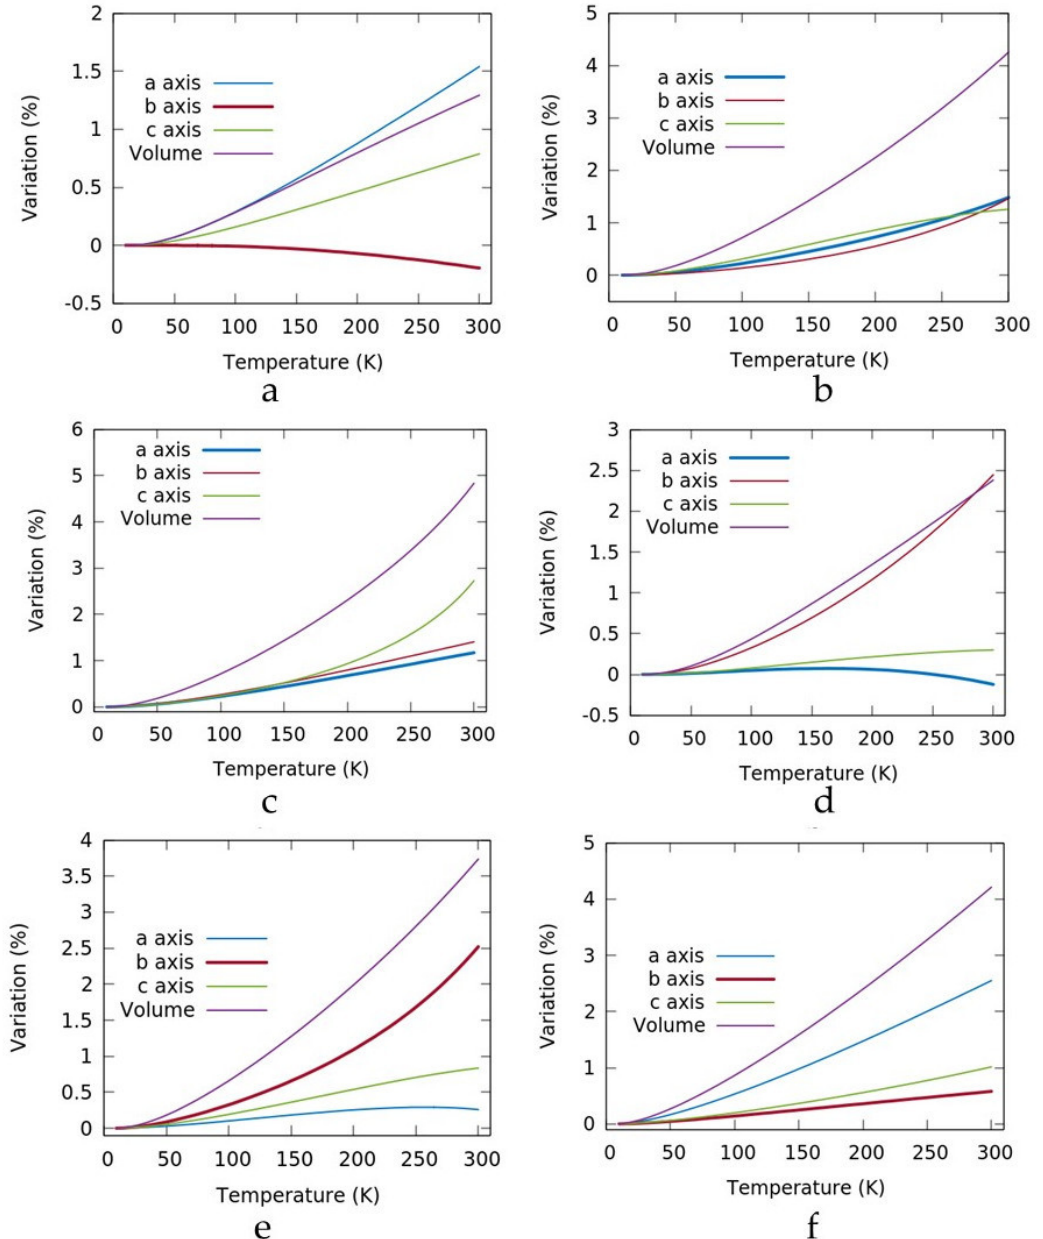
Figure 3. Plots of the relative variations of the cell axes and the cell volume for metoprolol ( a ), betoxolol ( b ), POLMET ( c ), KAZPOQ ( d ), PROPRA10 ( e ), and IMITON ( f ) between 10 K and 300 K. The values are normalized respect the value at 10 K. The axis parallel to the hydrogen bond columns is highlighted with a broader line. Table 1. Cell parameters (Å) at 10 K and at 300 K and their calculated variations using Quasi Harmonic Approximation. The values in bold refer to the axis parallel to the hydrogen bond columns. A b